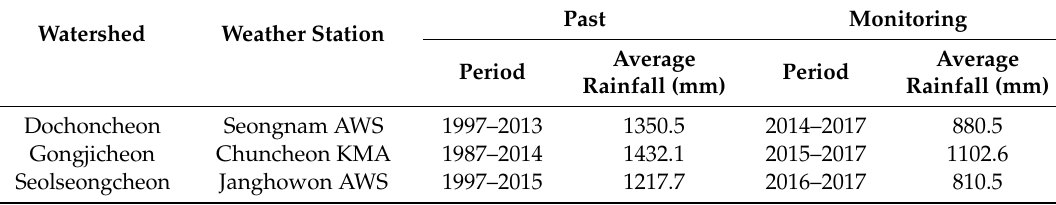
Table 3. Rainfall for each watershed during the study